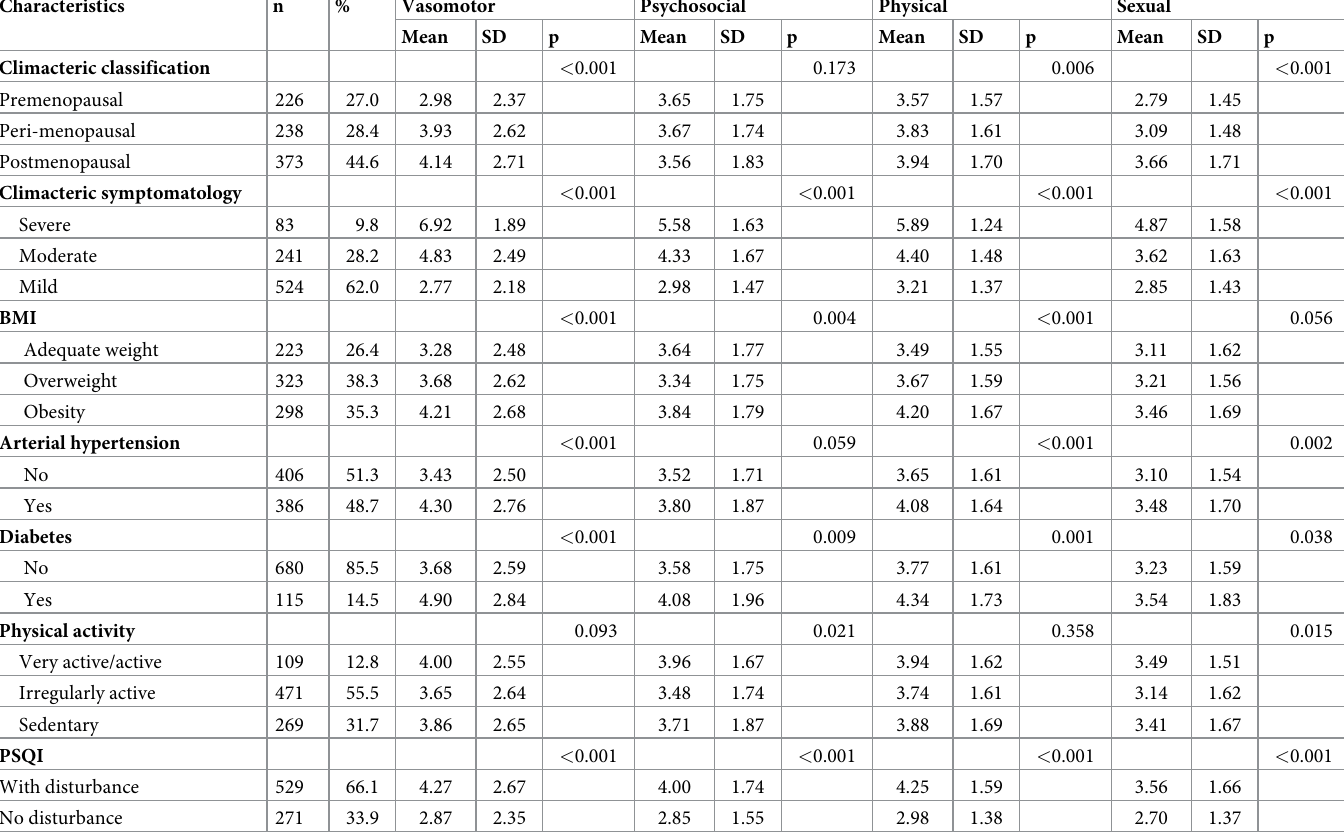
Table 4. Life and health habits of climacteric women assisted by primary health care according to MENQOL domain, 2015. Characteristics